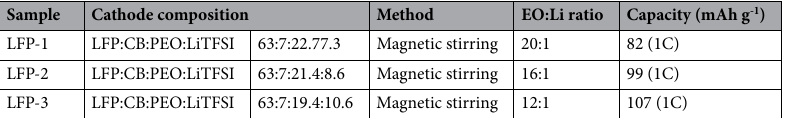
Table 1. Influence of EO:Li ratio in LFP cathode on electrochemical performance. The batteries were tested at different C rates (ranging from 0.1C to 1C) at 70 °C for 30 cycles using Li/SPNE/LFP